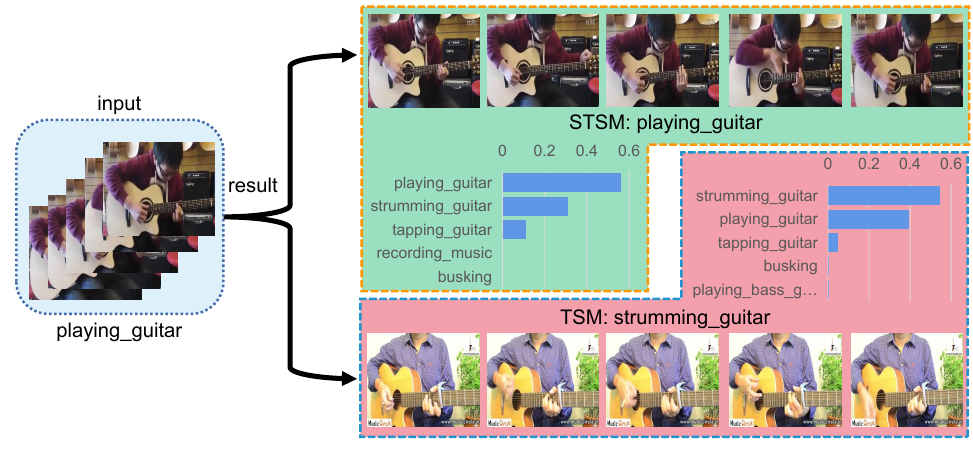
Figure 6. The top five results of STSM and TSM of the playing guitar sample.